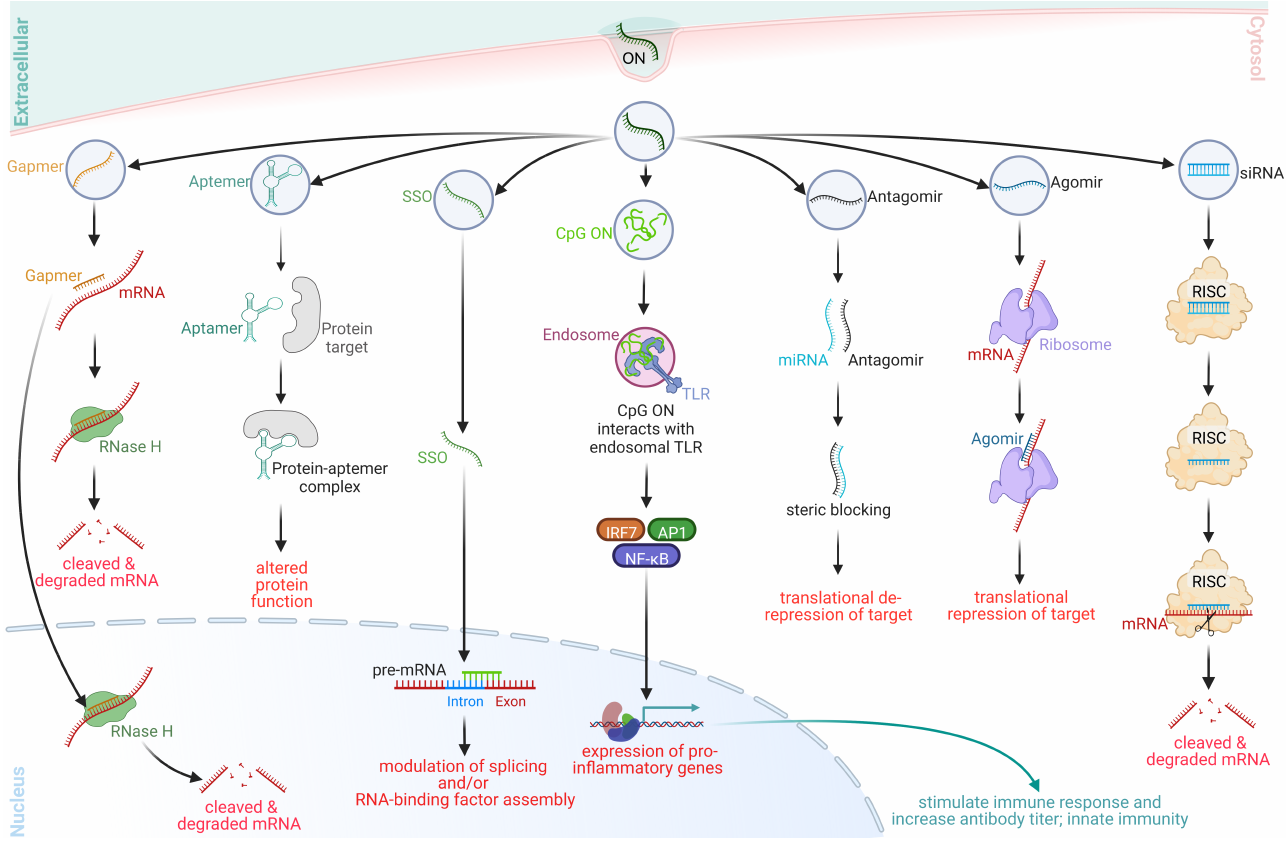
Figure 2. This is a wide figure. Figure 1. ON-mediated gene regulatory mechanisms and their location of action. The simplified mechanistic actions of (from left to right) gapmers, aptamers, steric blocking antisense ONs (SSOs), immunostimulant CpG oligodeoxynucleotides (CpG ON or CpG ODN), antagomirs, agomirs, and siRNA are shown with their respective cellular localization of activity. Gapmers induce the cytosolic or nuclear degradation of target mRNA, while aptamers modulate target protein function similar to monoclonal antibodies. SSOs modulate splicing and the assembly of RNA-binding factors, while CpG ONs stimulate the immune response. Antagomirs and agomirs, on the other hand, target miRNAs and their translational regulation, respectively. siRNA, on the other hand, triggers the RNA-induced silencing complex-mediated cleavage of mRNA (Created with BioRender: